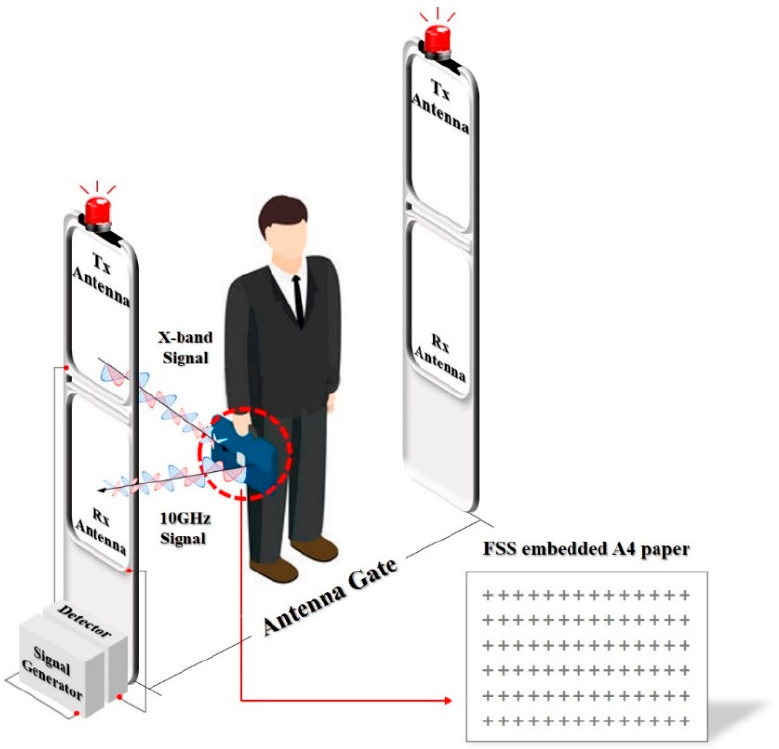
Figure 1. Operation principle of security paper detecting system.